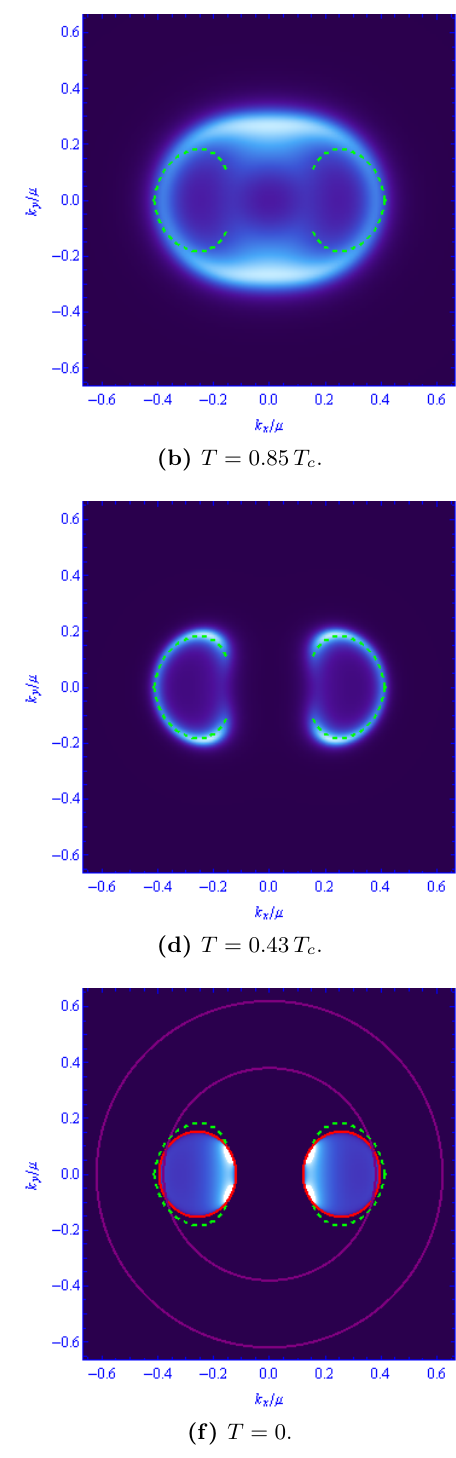
Figure 7. The spectral function for di(cid:11)erent temperatures and (cid:12)xed (cid:21) = 0 : 40 < (cid:21) c , ! = 0 : 12 (cid:22) . It is observed the presence of spherical symmetry at T = T c . The dashed lines indicates the locus of the normal modes. The purple and red circles represent the UV and IR Dirac cones respectively.